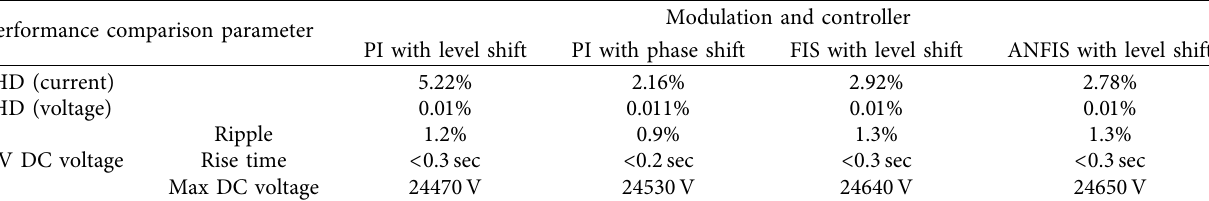
Table 2: Performance comparison of PI, FIS, and ANFIS.